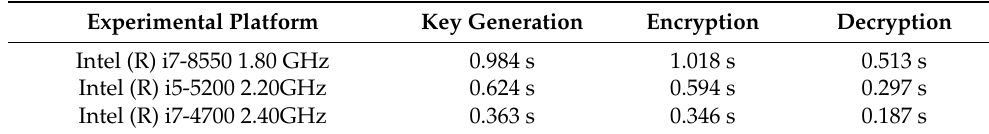
Table 3. Timings for cryptographic operations in our cryptosystem. Experimental